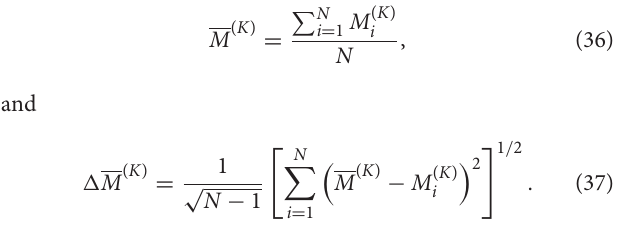
TABLE 6 | Average values of NTMEs M (0 ν ) , M (0 N ) , M ( χ ) CR , and M (χ) 100 Mo, 110 Pd, 128,130 Te, and 150 Nd isotopes (a) with and (b) without SRC1 [39,